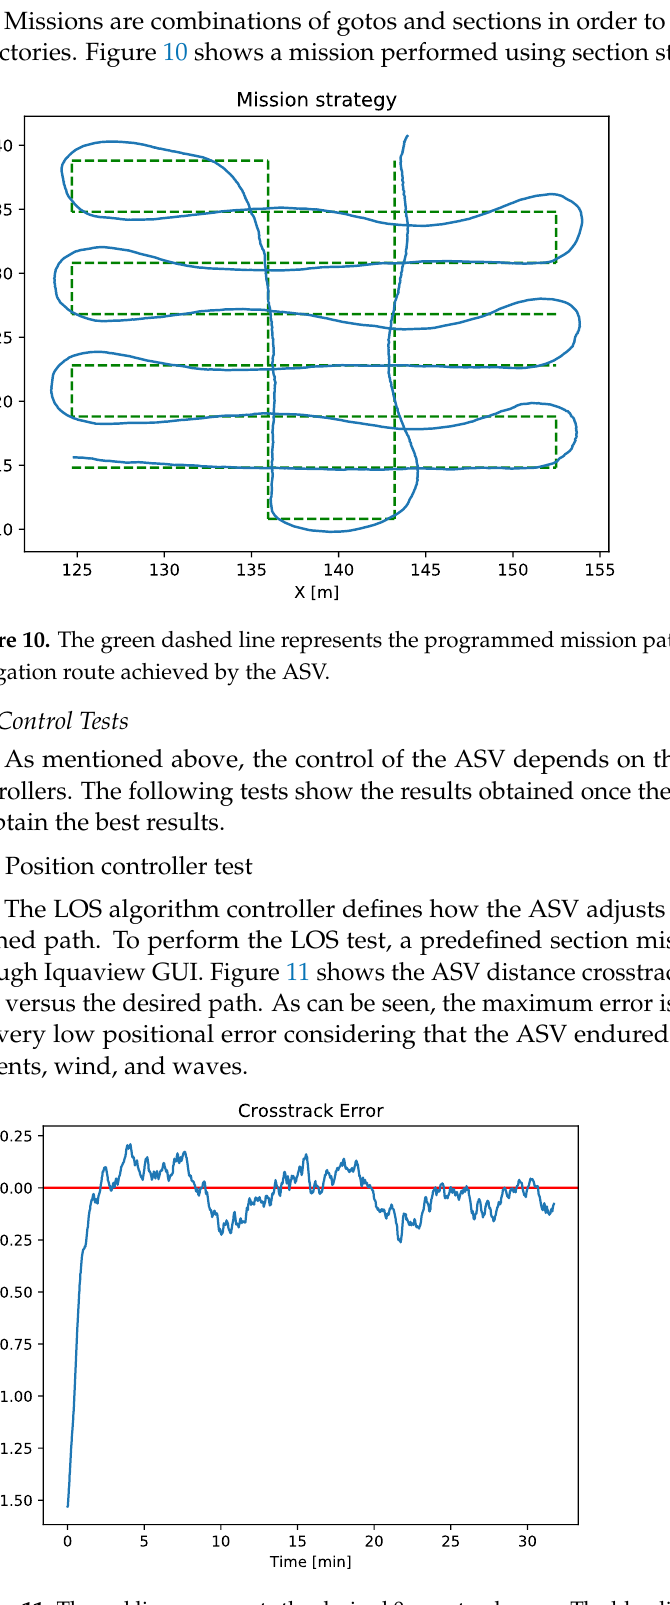
Figure 11. The red line represents the desired 0 crosstrack error. The blue line represents the evolution of the crosstrack error throughout a mission. The sample mean between minutes 2 and 31 is -0.017 and the standard deviation is